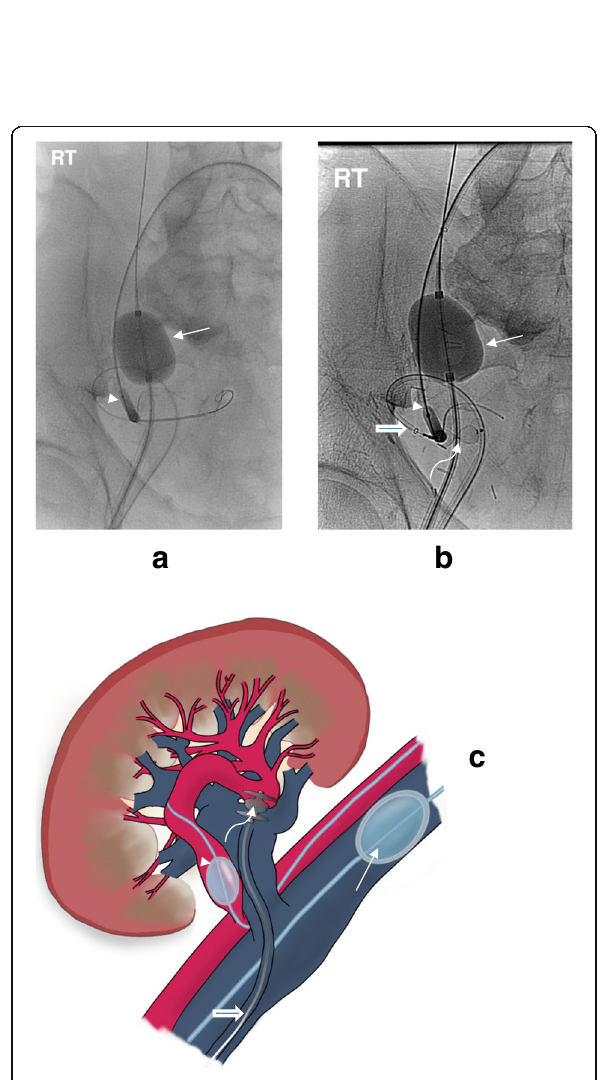
Fig. 3 Super-selective embolisation of the AVF. a and b Transient balloon occlusion of the artery (arrow head) and common iliac vein (white arrow) to allow advancement of the sheath (solid arrow) and deployment of Amplatzer plug (curved arrow) across AVF. c Schematic diagram demonstrating the above embolisation